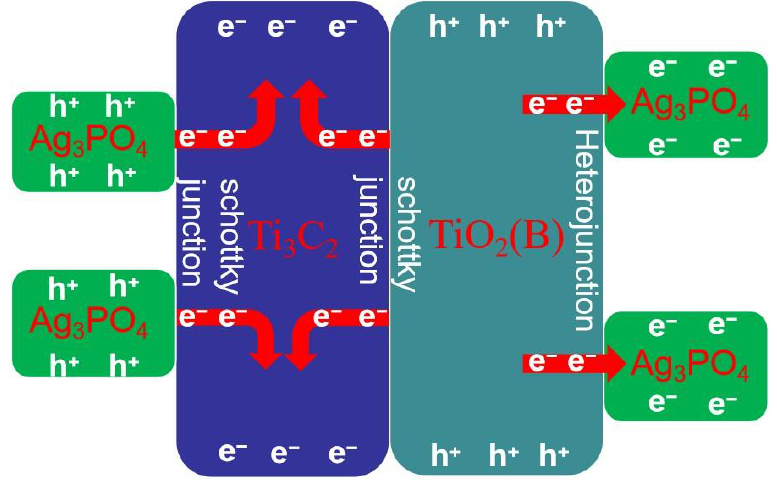
Figure 7. Mechanism of enhanced photocatalytic properties.